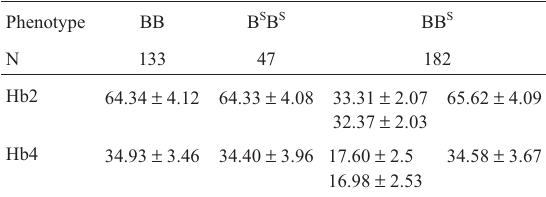
Table 1 - Mean values and standard deviation of densitometric data ob- tained analysing buffalo Hb bands.